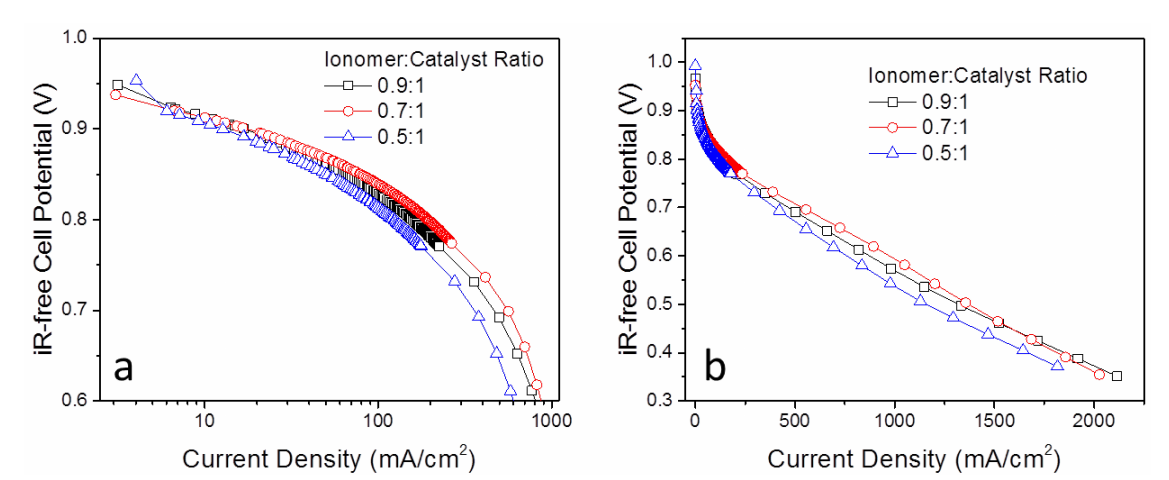
Figure 3. ( a ) Tafel plots from samples prepared with different ionomer to catalyst ratios. ( b ) Polarization curved corresponding to the Tafel plots shown in ( a ). The current density at 0.8 V for 0.9:1 = 158.4 mA cm − 2 , 0.7:1 = 194.0 mA cm − 2 , and 0.5:1 = 123.5 mA cm − 2